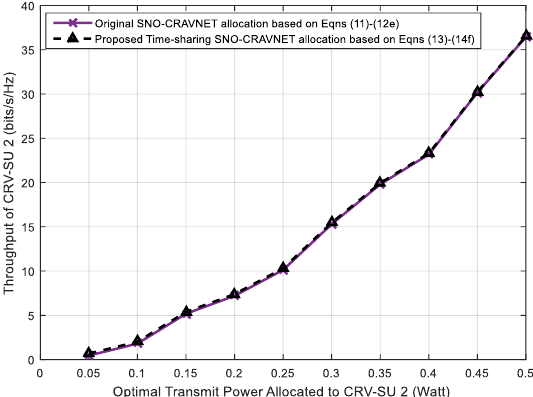
Figure 8. Performance evaluation using optimal throughput measured against the optimal supplied transmit power for CRV-SU 1. Sensors 2020 , 20 , x FOR PEER REVIEW 21 of 27